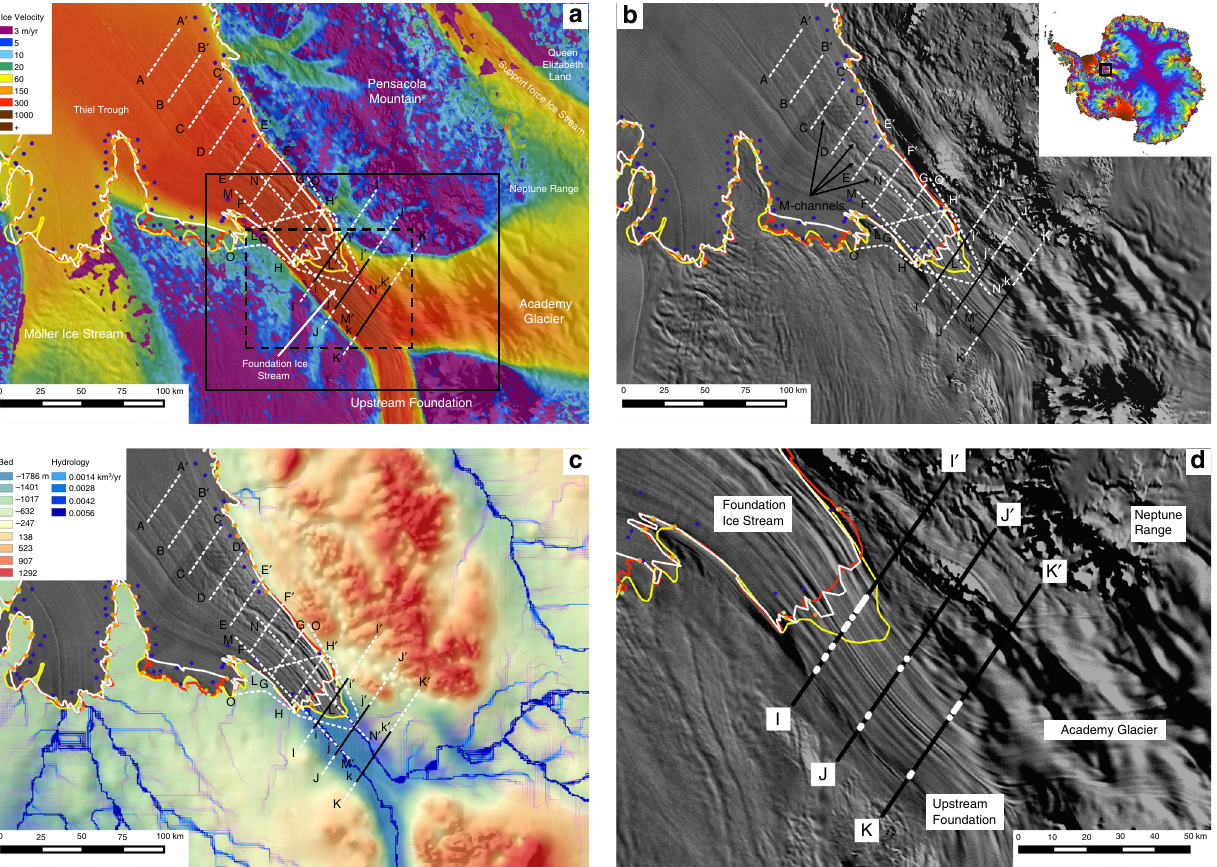
Fig. 1 Ice-surface imagery, bed elevation, ice-surface velocity, and subglacial water fl ow for the Foundation ice stream. a Ice-surface velocities 49 underlain by MODIS ice-surface imagery (solid-line box outlines refer to magni fi ed region in ( d ) and dashed-line box is in Supplementary Figure 4). Grounding points from the Ice, Cloud, and land Elevation Satellite (ICESat) laser altimetry are as follows: in blue — hydrostatic point; orange — ice fl exure landward limit; and green — break in slope 47 . Grounding lines are from the Antarctic surface accumulation and ice discharge (ASAID) (red) 13 , the differential satellite synthetic aperture radar interferometry (DInSAR) (yellow) 14 , and the mosaic of Antarctica (MOA) (white) 48 . b MODIS ice-surface imagery of the Foundation ice stream trunk. Meandering lineations downstream of the grounding line are noted as “ M-channels ” . Radar transects, annotated as in other fi gures, are shown. The inset denotes the location of the study region in Antarctica. c Bed elevation 23 and subglacial-hydrological pathways (calculated as discharge rates). d Regions of enhanced basal re fl ectivity (>5 dB, noted in white lines) along three transects, superimposed over MODIS imagery 50 and the grounding lines as in ( a